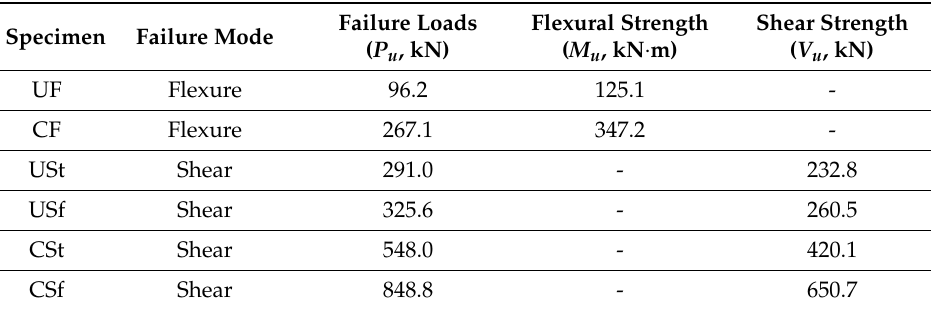
Figure 5. Load-deflection responses of flexural test specimens. Table 2. Summary of test results.